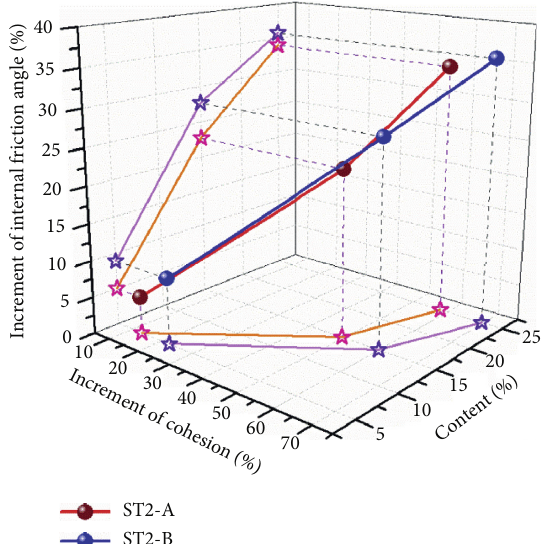
Figure 11: The increment of cohesion and internal friction angle of grouting samples compared with the undisturbed